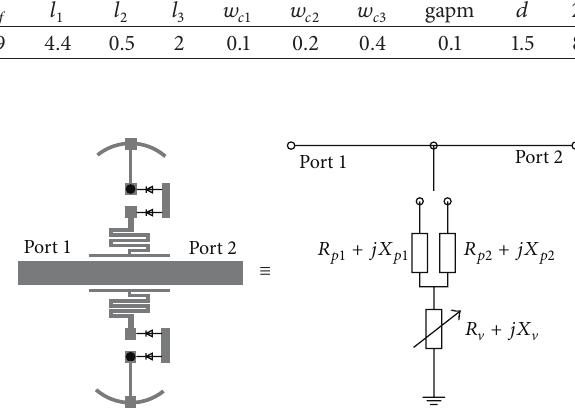
added into 𝑅 V + 𝑗𝑋 V for simplicity. When the resonance of series circuit happens, signal will not transfer from port 1 to port 2 but will pass through the circuit to the ground, as if port 2 is shorted, and this is the reason that the notch band shows up on the UWB spectrum.